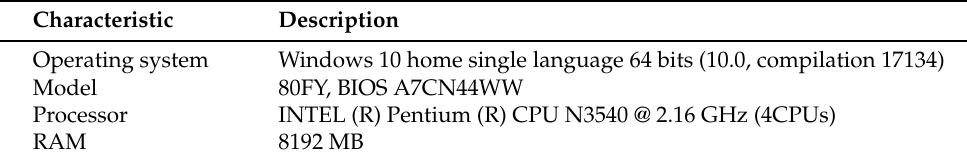
Table 3. Characteristics and its description of the computer used in the experimental studies.